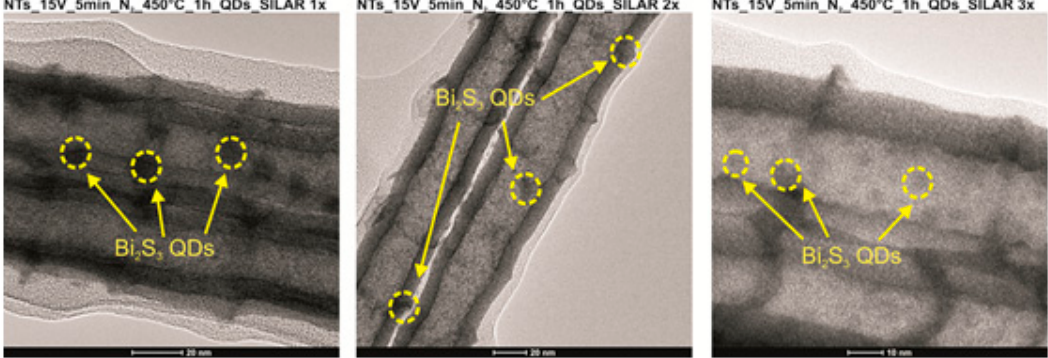
Figure 5. Transmission Electron Microscopy (TEM) images for nanotube arrays (NTs) modified by bismuth sulfide (Bi 2 S 3 ) quantum dots (QDs).